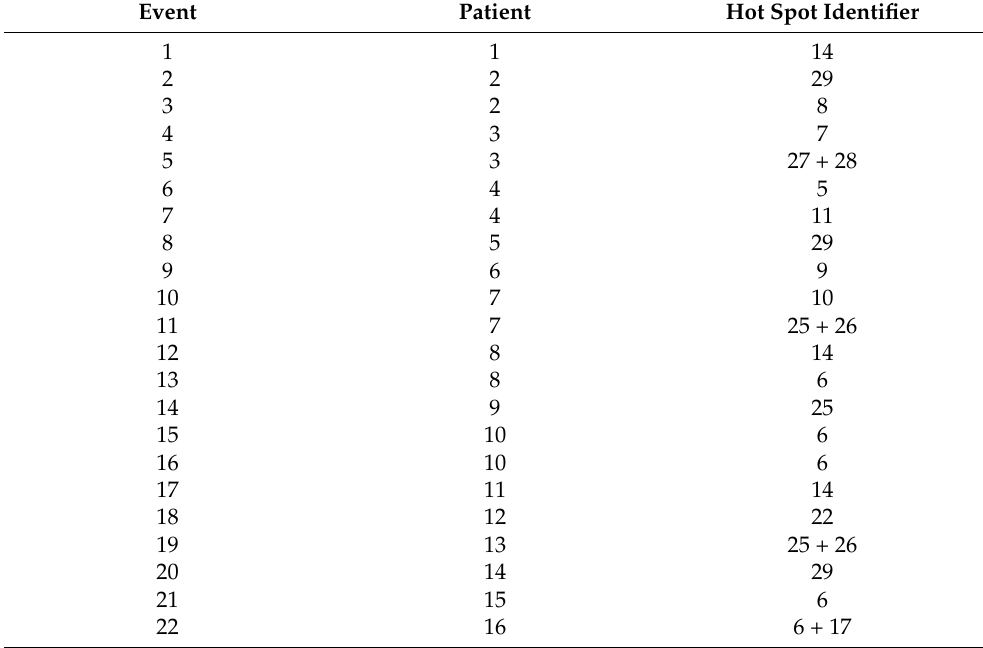
Table 2. Registered treatment limiting hot spot locations for the patients and events included in this study. Anatomical location of hot spot location identifiers is shown in Figure